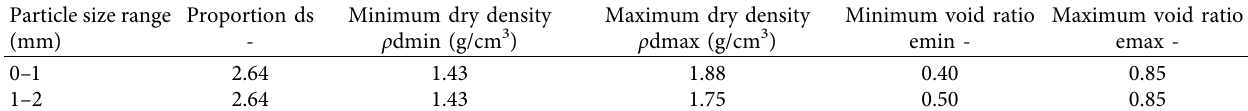
Table 2: Physical parameters of Fujian sand.